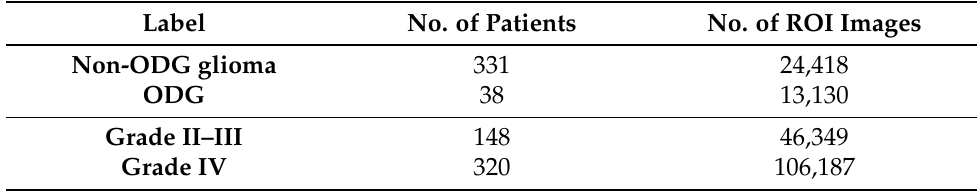
Figure 1. Schematic illustration of the study design and dataset selection. ROI; region of interest. Table 1. The dataset of diffuse